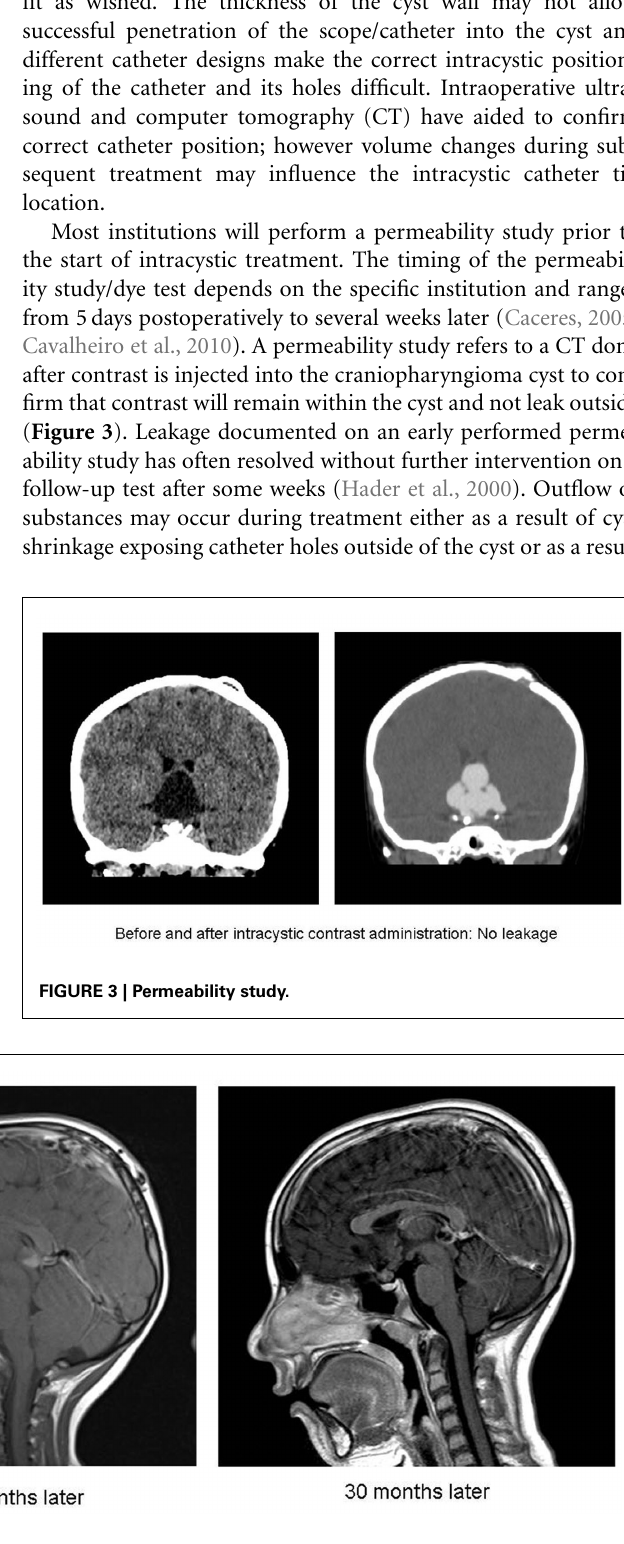
FIGURE 2 | Child with complete maintained response after 2 courses with intracystic